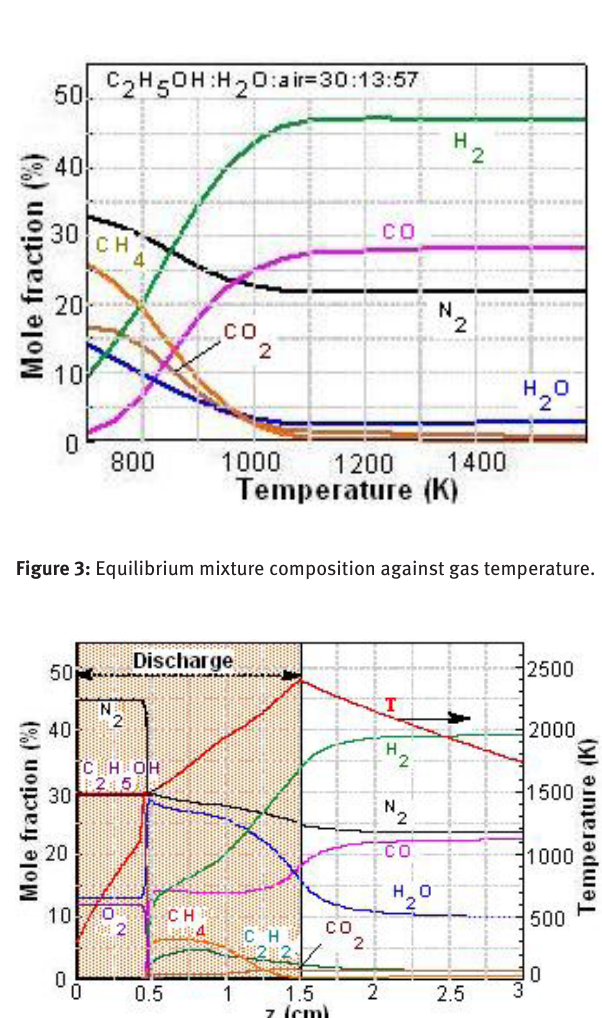
Figure 4: Axial concentration and temperature profiles in reactor.